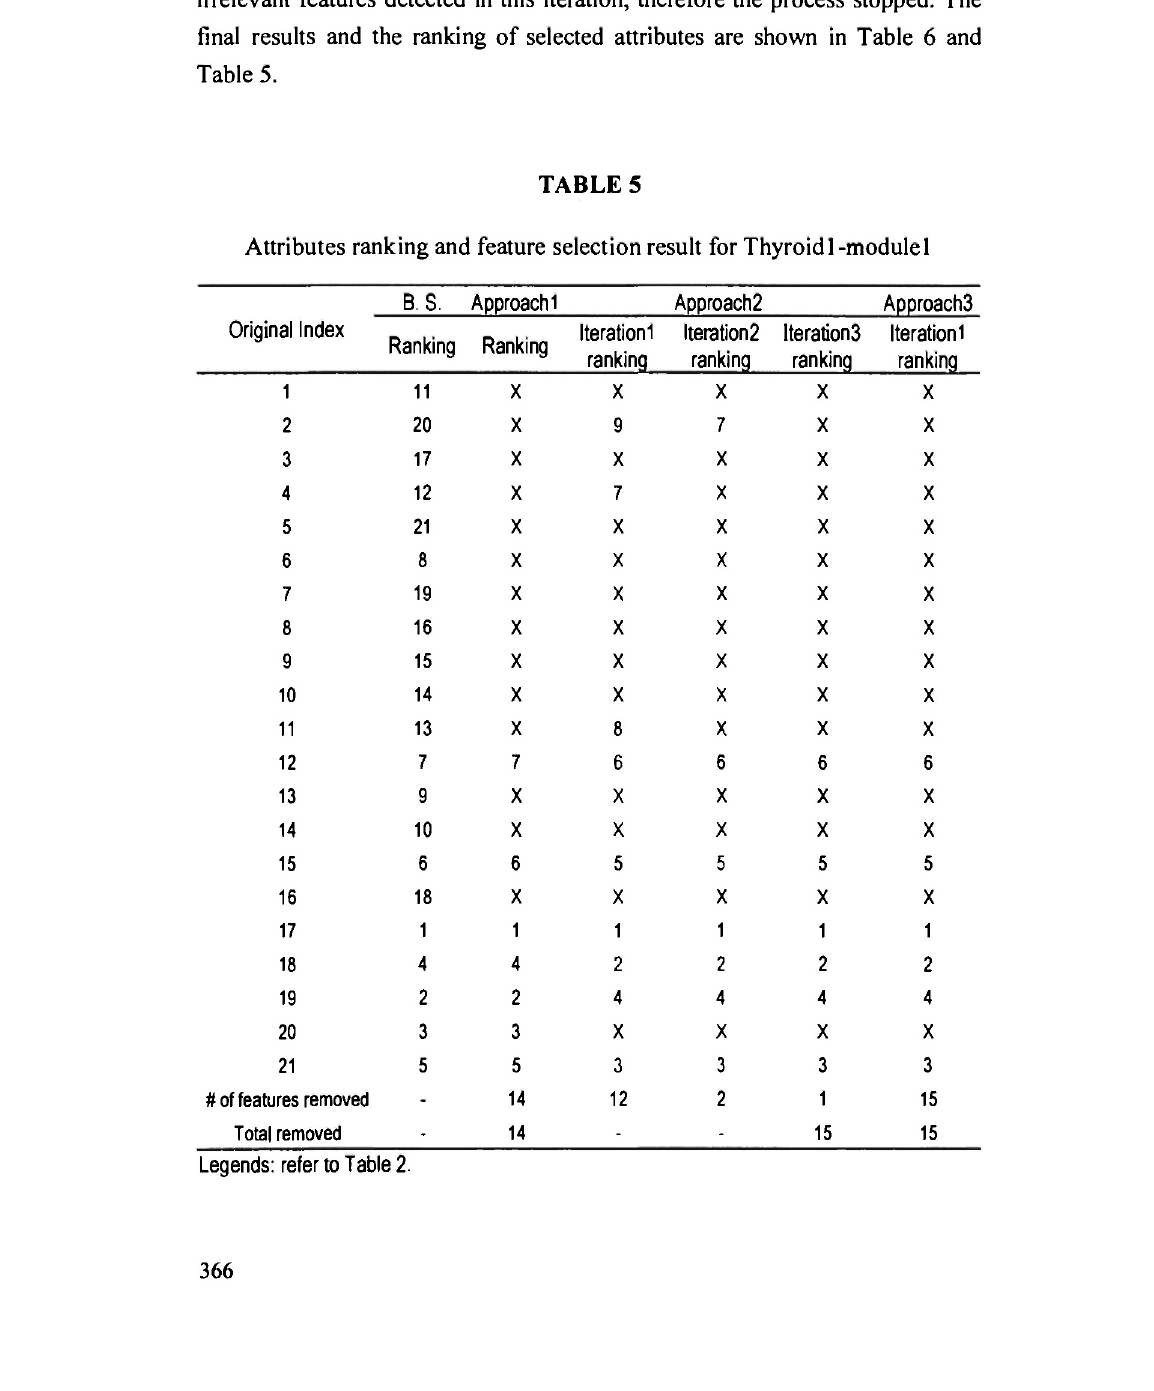
Attributes ranking and feature selection result for Thyroid 1-module